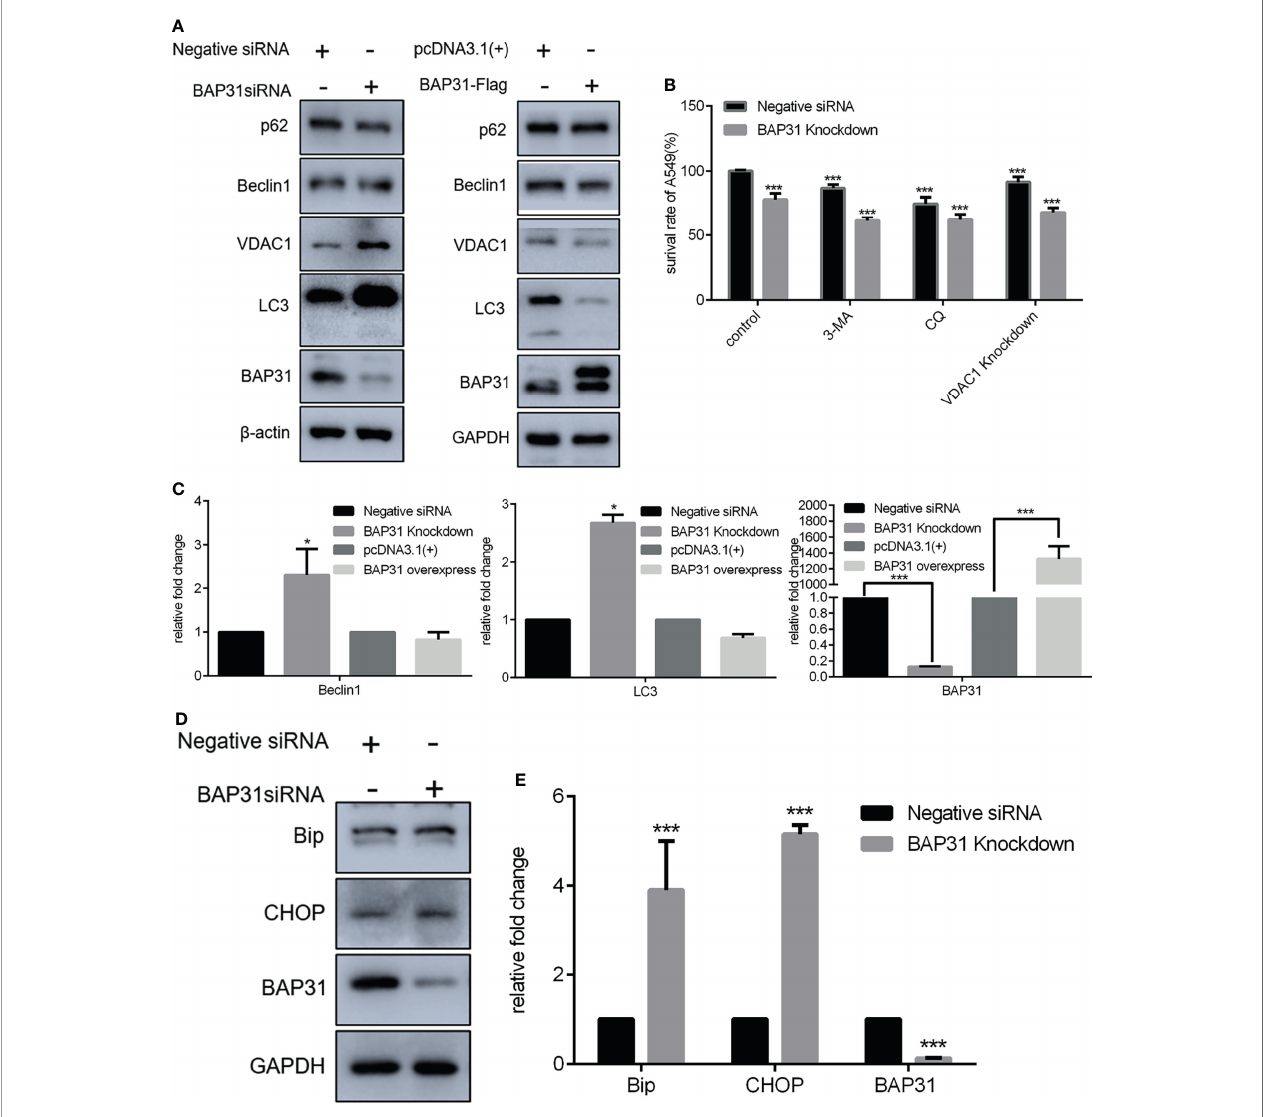
FIGURE 3 | Expression of genes related to homeostasis in lung cancer cells after altering BAP31 expressing. (A) Expression of autophagy associated genes as assessed by Western blot in the cells transfected with BAP31 siRNA, or BAP31 overexpressing plasmid (pcDNA3.1(+)-BAP31-Flag). (B) The survival of lung cancer cells was examined by the CCK-8 assay. The BAP31 siRNA knockdown cells received combinatorial treatment with 3-Methyladenine (3-MA), Chloroquine (CQ) or VDAC1 siRNA. (C) Expression of autophagy associated genes was determined by qPCR (mean ± SEM of duplicate experiments). (D) Expression of ER stress related genes as assessed by Western blot. (E) Expression of ER stress associated genes was determined by qPCR (mean ± SEM of duplicate experiments). * p < 0.05 versus control and *** p < 0.001 versus